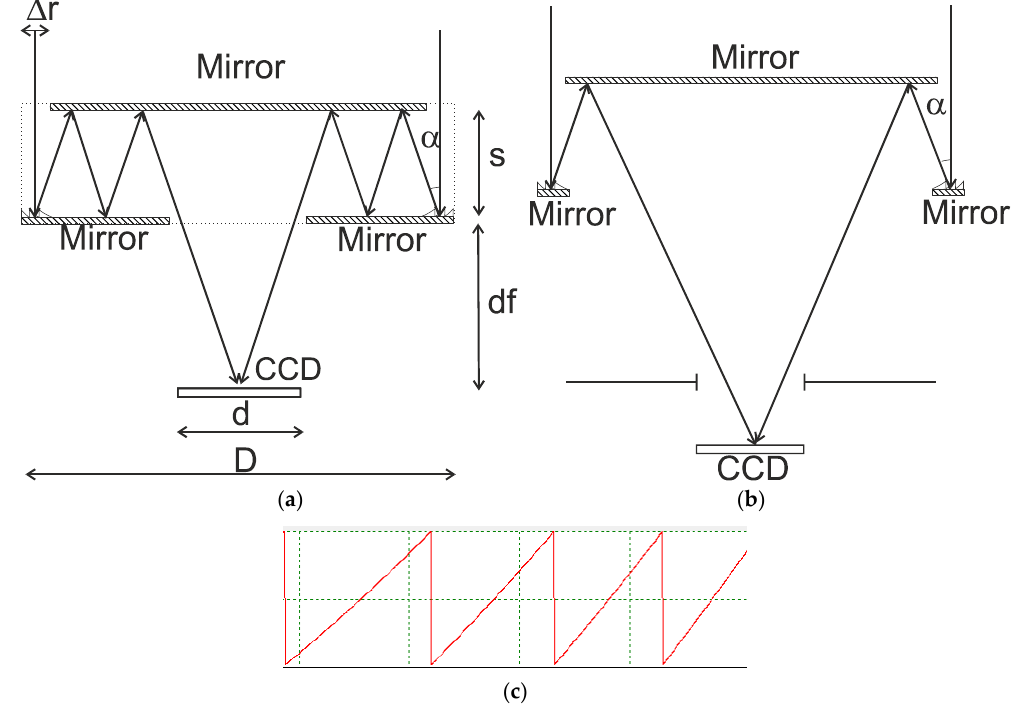
Figure 1. ( a ) A planar annular imaging objective; ( b ) Its equivalent without multiple reflections; and ( c ) The total cross-section of the microrelief of an annular harmonic parabolic lens of height 10 µm. CCD, charge-coupled device; D is the lens diameter; d is the central opening diameter; s is the plate thickness; ∆ r is width of the annular aperture; and df is working distance.